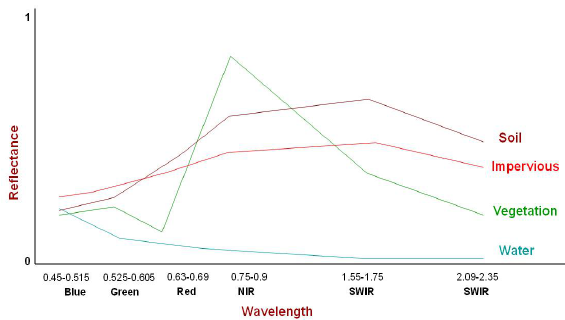
Figure 1. Trend of Spectral characteristics for four land